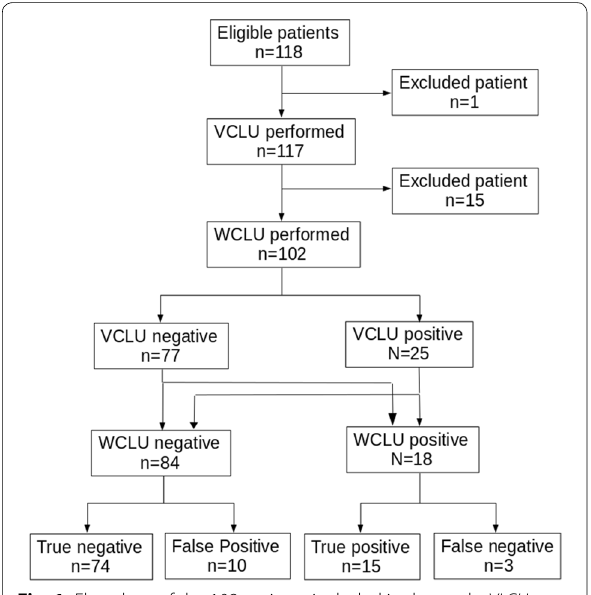
Fig. 1 Flowchart of the 102 patients included in the study. VLCU venous limited compression ultrasonography, WLCU whole leg